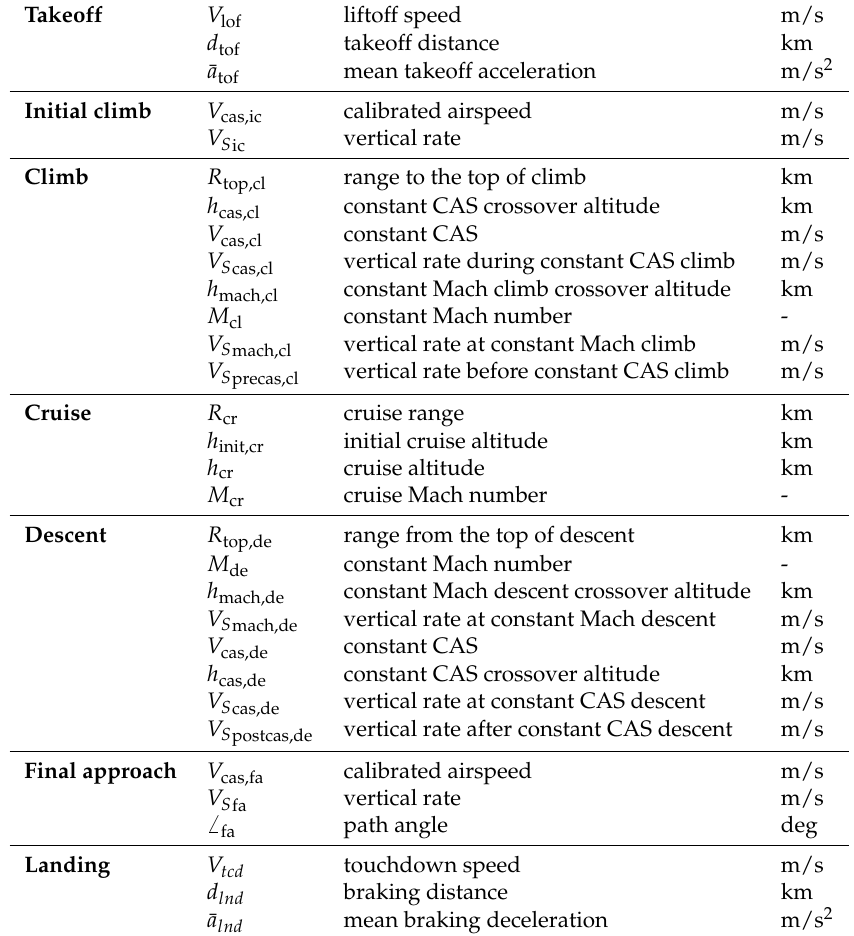
Table 2. Performance parameter in OpenAP kinematic